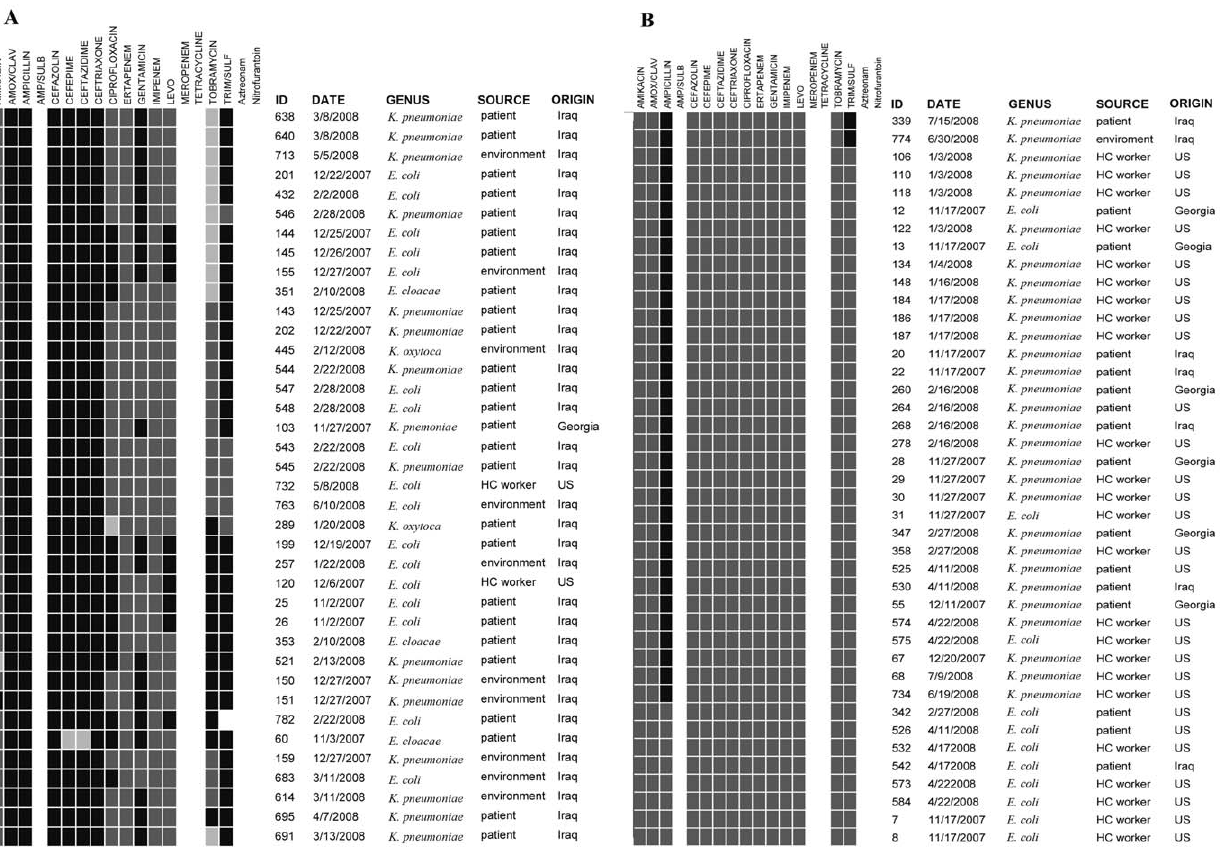
Figure 1. Antibiograms and basic epidemiological characteristics of both MDR (A) and non-MDR (B) bacteria isolates. Solid black: resistance to the antibiotics; Grey: susceptible to the antibiotics; Light grey: intermediate; White: N/A; ID: strain identification. HC worker: Healthcare worker.